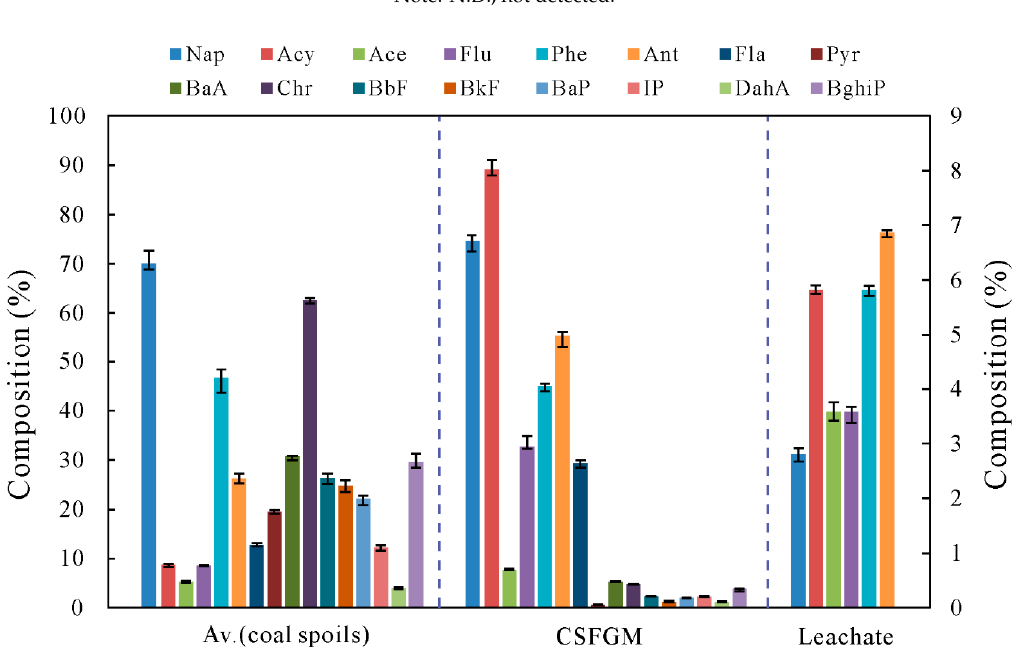
Figure 3. Distribution patterns of PAHs in coal spoils, CSFGM, and Leachate (Av.(coal spoils) is the average value of PAHs of the four coal spoil samples; Nap composition is shown in the left Y-axis, other PAHs composition is shown in the right Y-axis).